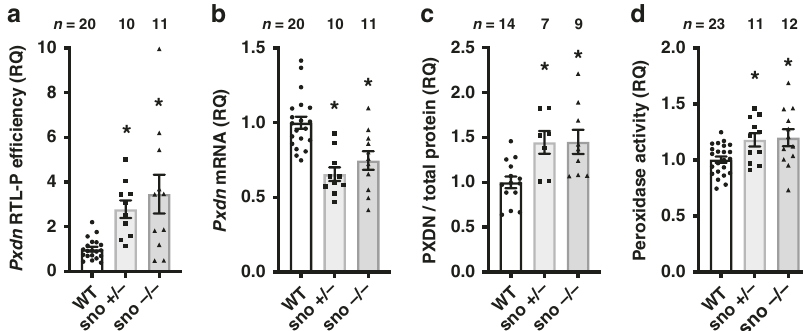
Fig. 3 snoRNA-guided 2 ′ - O -methylation regulates Pxdn mRNA expression, protein levels, and peroxidase activity in vivo. a – d Hearts from WT, sno + / − , and sno − / − mice were analyzed. Plots show mean ± SEM, normalized to WT control as relative quantities (RQ). * p < 0.05 vs. WT by one-way ANOVA. a Pxdn mRNA had less Nm in both sno + / − (* p = 0.021) and sno − / − (* p = 0.0007), vs. WT. b Pxdn mRNA abundance was reduced in sno + / − (* p = < 0.001) and sno − / − (* p = 0.0019) mice, vs. WT. c PXDN protein expression was higher in sno + / − (* p = 0.0163) and sno − / − (* p = 0.0079) mice, vs. WT (by immunoblotting with normalization to total protein per lane). d Peroxidase activity was higher in sno + / − (* p = 0.0447) and sno − / − mice (* p = 0.0177) vs. WT, as measured using Amplex